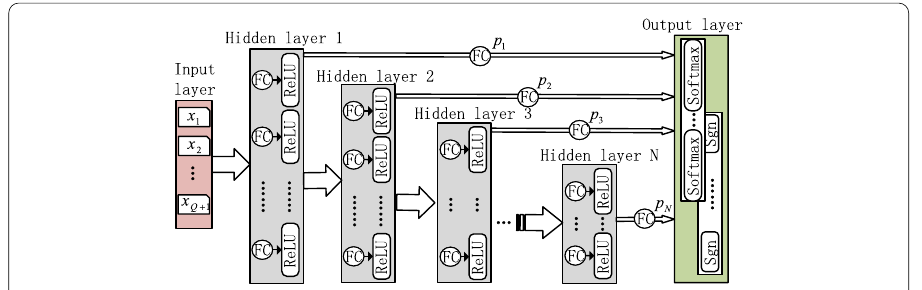
Fig. 5 The multipath DNN architecture. A multipath DNN architecture with N hidden layers. In figure, each hidden layer is composed of a FC sublayer and a ReLU sublayer in series. Each hidden layer has an exit, and the probability of exiting at this layer is p